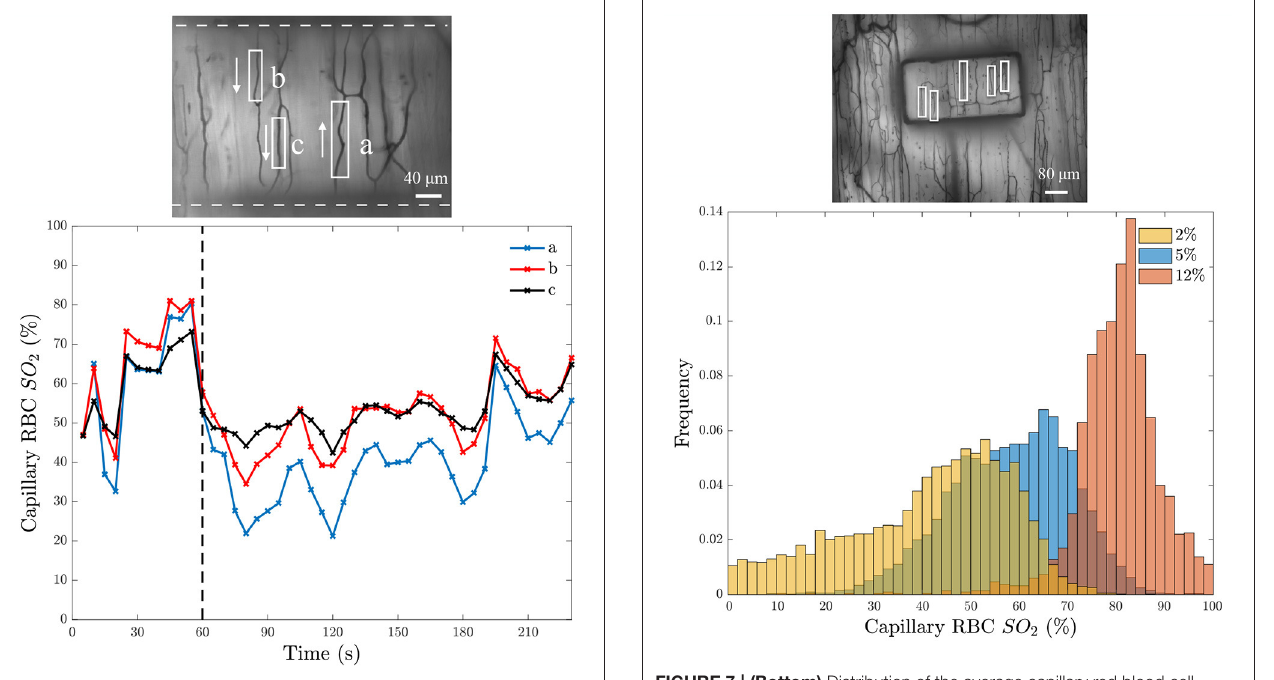
FIGURE 6 | Capillary red blood cell oxygen saturation in response to a step change in O 2 . The bottom panel shows mean capillary red blood cell (RBC) oxygen saturation (SO 2 ) of 5-s bins from three separate capillaries in the same field of view over time; the time at which O 2 was changed is indicated with the black dashed line. The field of view from which the measurements were taken is represented by the intravital microscopy functional image of the minimum pixel intensity over the duration of the video shown in the top panel. The analyzed capillaries in the top panel are identified by white boxes, with arrows to indicate the direction of RBC flow, and the white dashed line indicates the position of the O 2 exchange window.